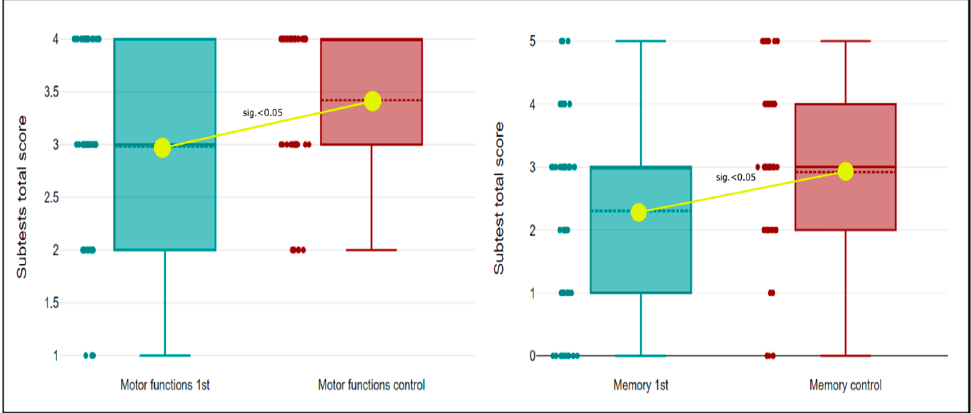
Figure 3. Box-plot diagrams. Comparison of cognitive subtests scores at discharge (green colour) and 6 months after stroke (red colour) in the domain of motor and constructional/visuospatial functions (left) and domain of memory (right). Mean score of subtests was significantly increased 6 months after stroke ( p -value < 0.05).